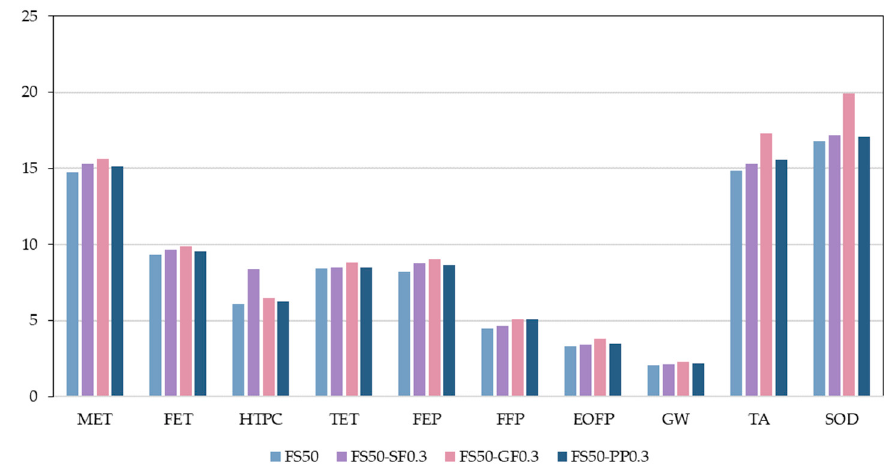
Figure 8. Normalization scores of FRAAC on midpoint impact categories.